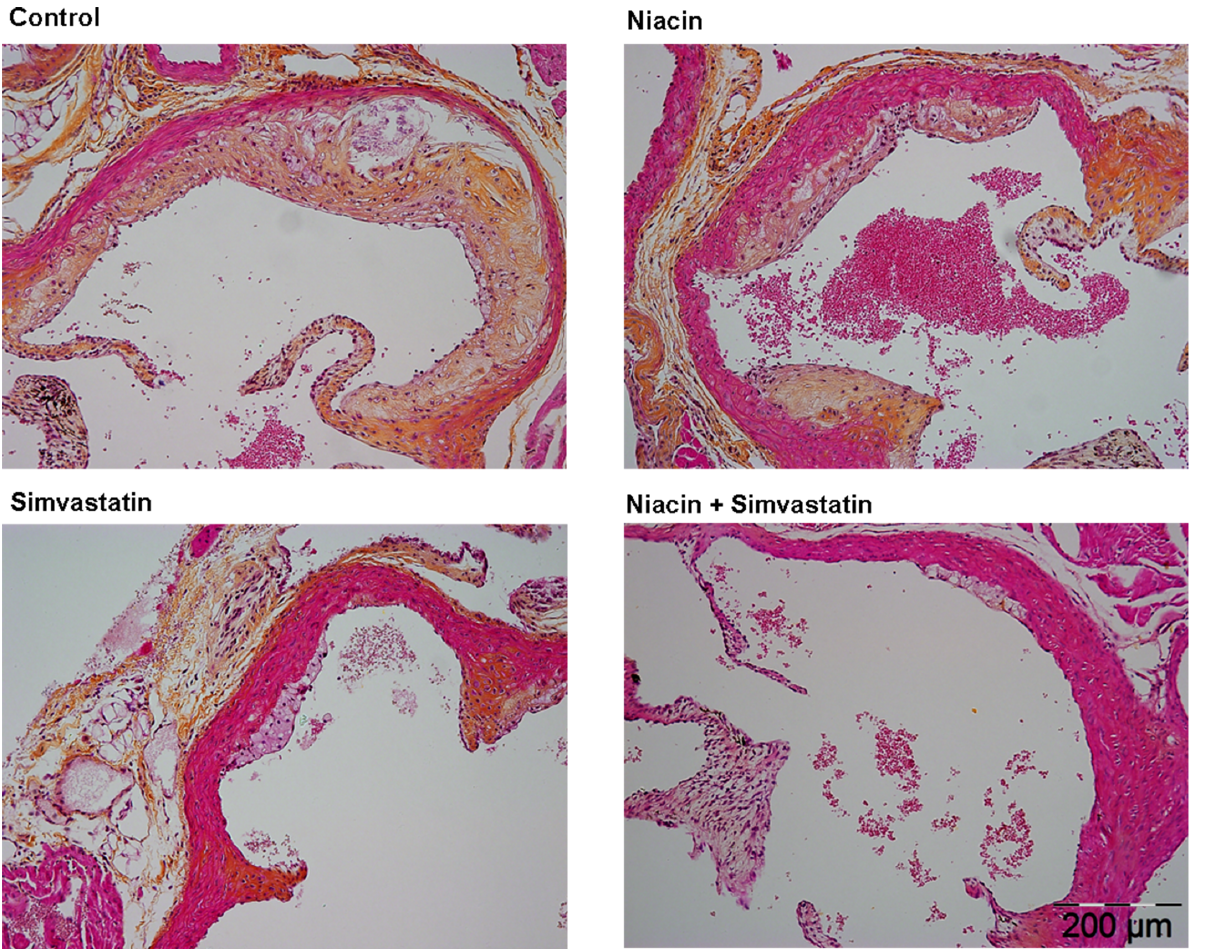
Figure 3. Effect of niacin, simvastatin and their combination on plaque morphology. Representative images of hematoxylin-phloxine- saffron-stained atherosclerotic lesions in a cross section of the aortic root area for the control group (A), niacin group (B), simvastatin group (C) and the combination group (D) after 18 weeks of treatment.